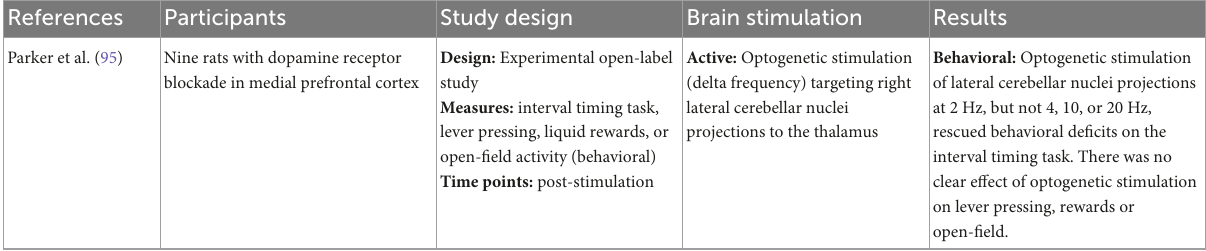
TABLE 2 Characteristics of pre-clinical studies reporting on cerebellar stimulation in rat models of schizophrenia.